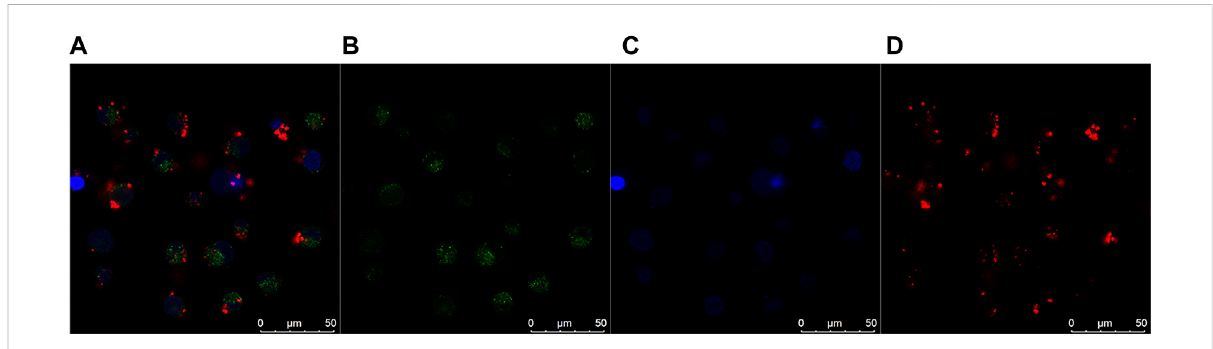
FIGURE 6 ConfocalcolocalizationimagesofB16cellsincubatedinQDs – AlPcSDMEMsolutionfor2 h. (A) Mergesofthreechannels. (B) Lysosomelabeled by LysoTracker Green DND-26 (green signals). (C) Nucleusdyedblueby Hoechst 33258. (D) Red fl uorescence exhibited by QDs – AlPcS irradiatedat 405 nm. Scale bar is 50